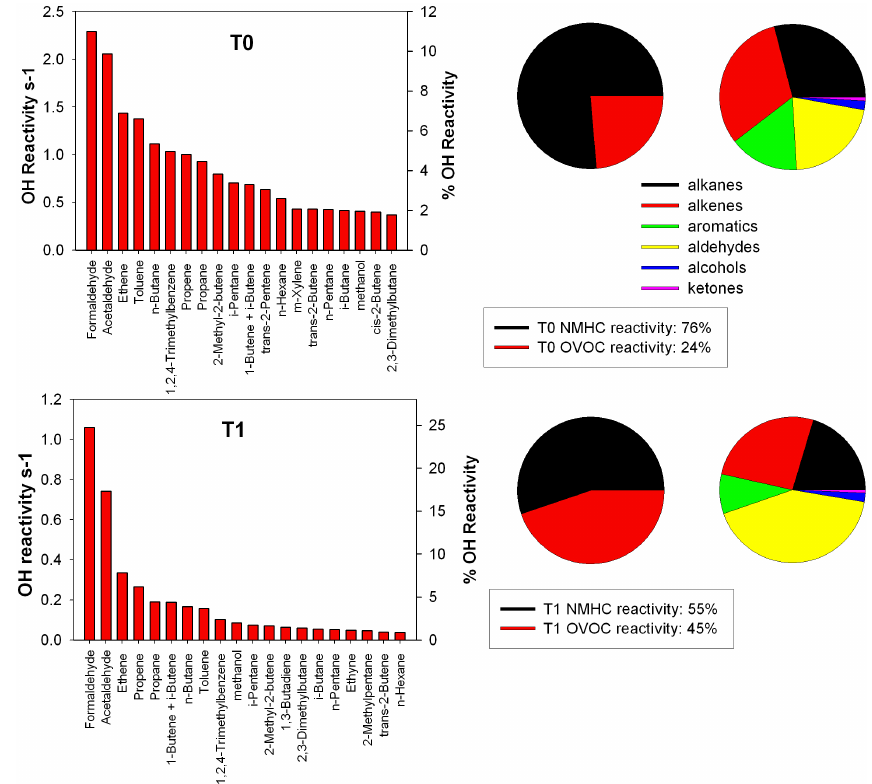
Fig. 9. The top 20 compounds measured at the supersites T0 (top panel) and T1 (bottom panel) in terms of OH reactivity between 09:00 and 18:00 local time averaged over the month of March, 2006. Shown in the first pie chart to the right of each bar graph is the breakdown for the relative contributions from NMHCs and OVOCs for T0 and T1, respectively. Shown in the second pie chart is the breakdown in terms of each compound